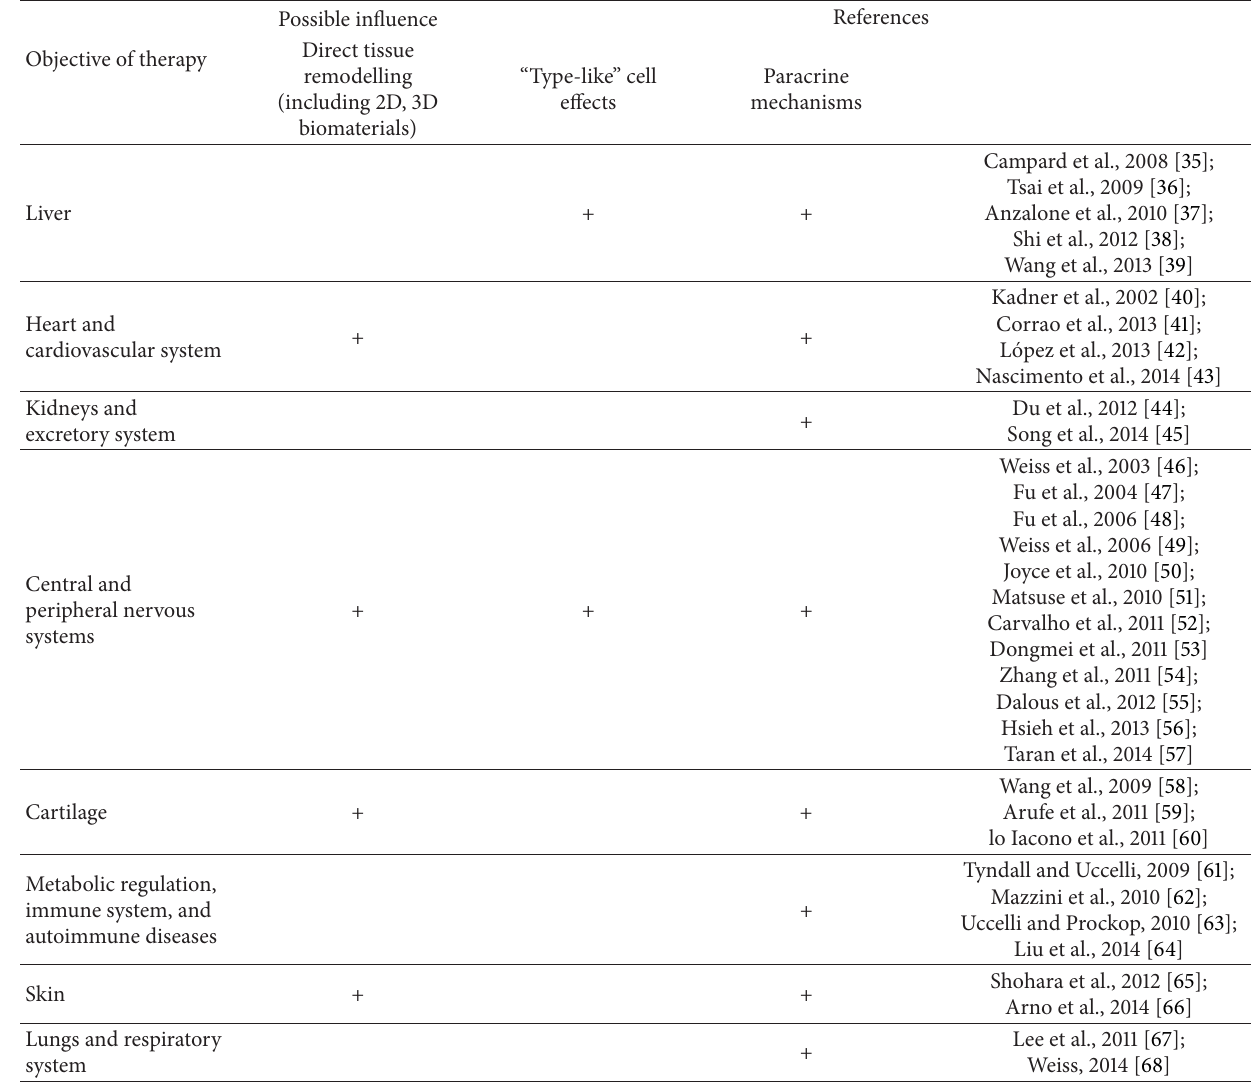
Table 1: Schematic summary of current data on the putative mechanisms of UC-derived cell